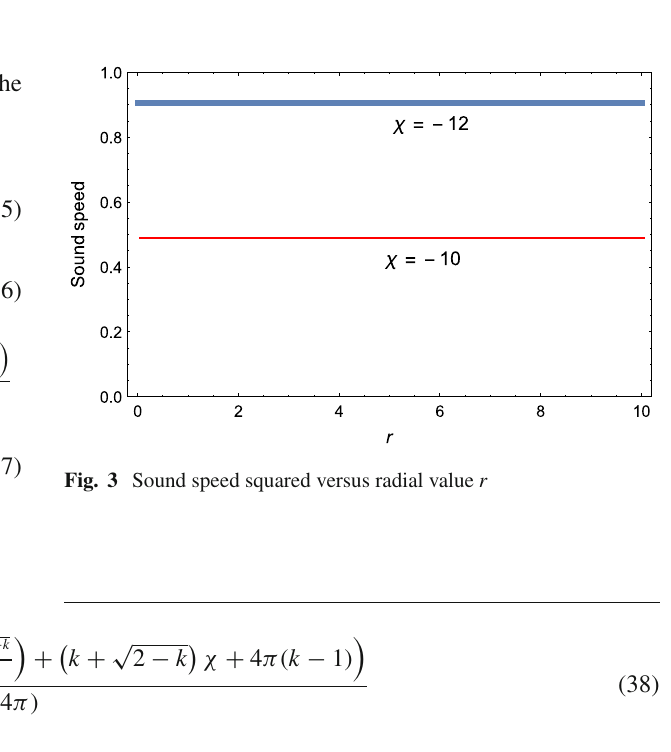
Fig. 1 Density versus radial value r Fig. 2 Pressure versus radial value r